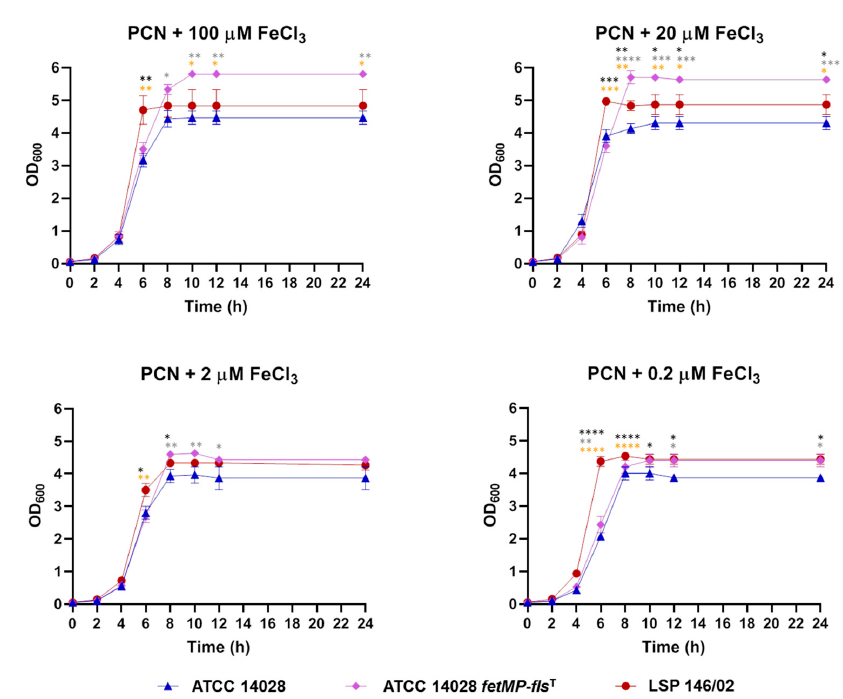
Figure 6. Growth curves obtained for S . Typhimurium ATCC 14028 with and without the cloned fetMP - flsDA genes (ATCC 14028 fetMP - fls DA T ) using a PCN medium supplemented with decreasing concentrations of FeCl 3 . The data shown are the mean values ± standard deviations of three biological replicates. Statistical significance (**** p < 0.0001; *** p < 0.001; ** p < 0.01; * p < 0.05) was determined by ANOVA and the Tukey’s post-test. Black, grey, and orange asterisks show significant differences for ATCC 14028 versus LSP 146/02, ATCC 14028 versus ATCC 14028 T , and LSP 146/02 versus ATCC 14028 fetMP - flsDA T , respectively.